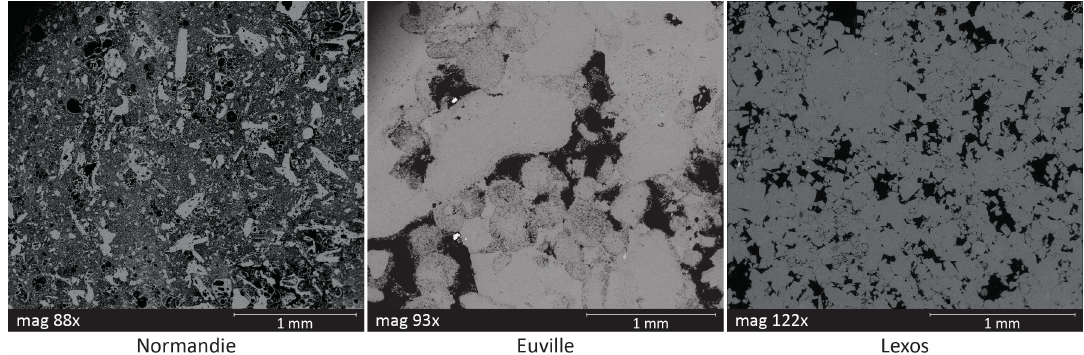
Figure 1. Images obtained by SEM: Normandie ( left ), Euville ( middle ) and Lexos ( right